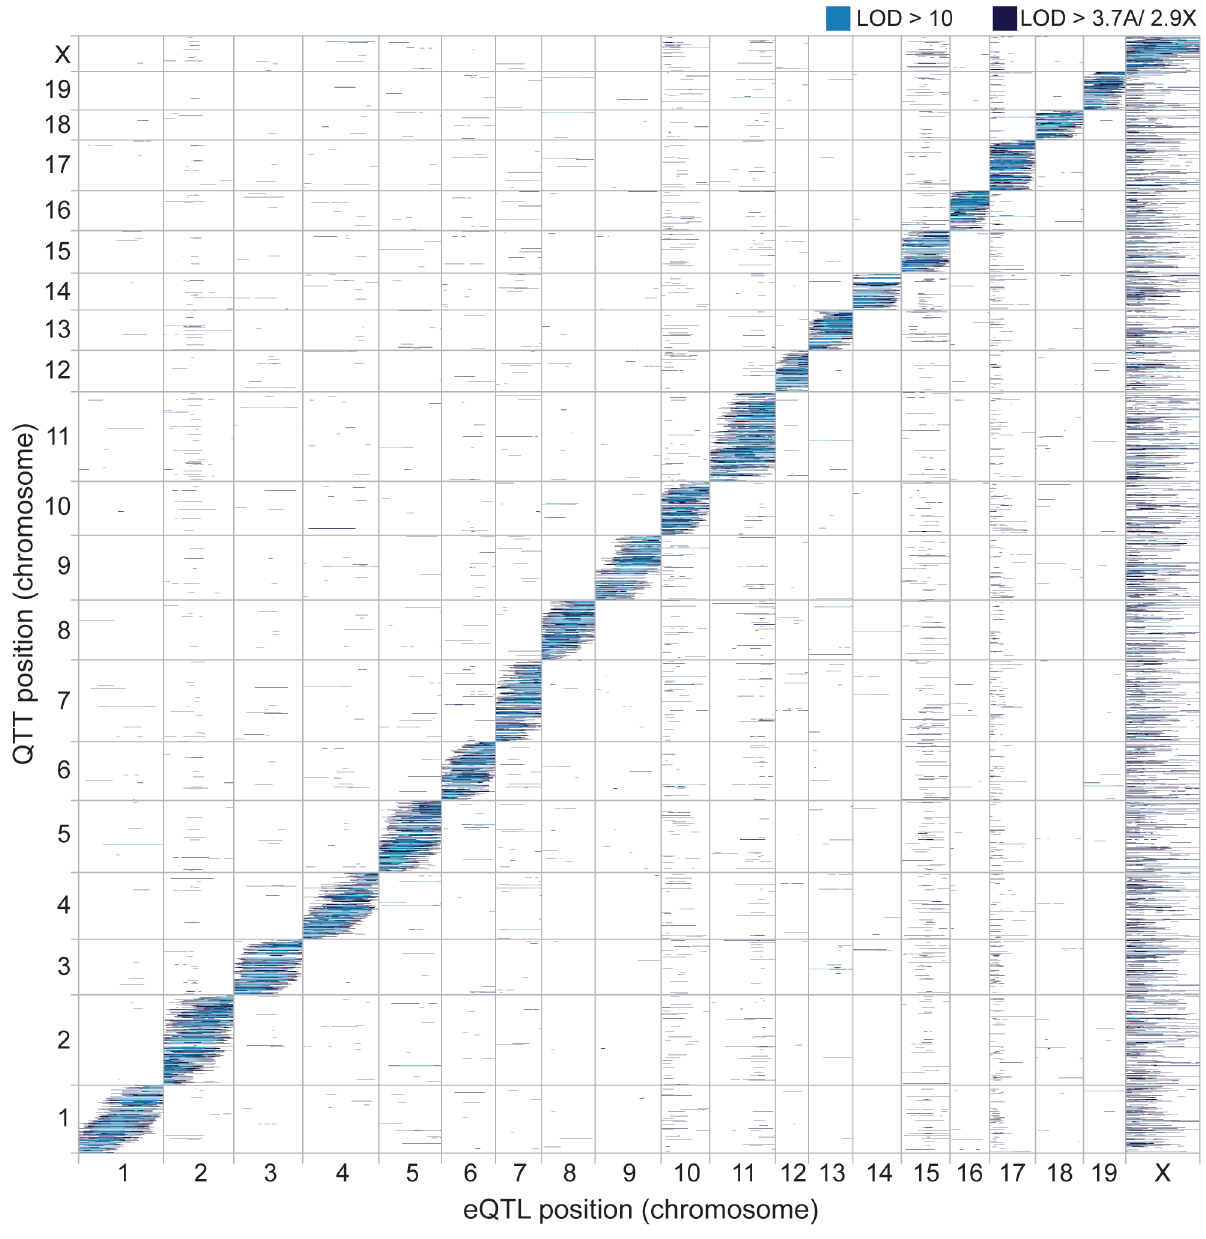
Figure 2. Genomic distribution of eQTL and QTT. Heatmap showing eQTL locations (marker/pseudomarker positions on x-axis) and transcript locations (y-axis). LOD scores above permutation thresholds are shown in dark blue and LOD scores . 10 in light blue.